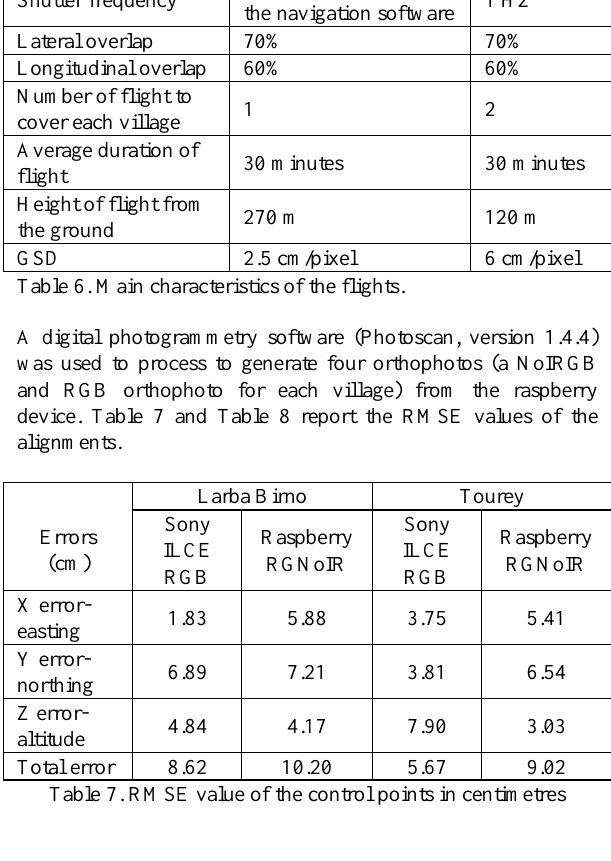
Figure 6: Area of the study. The villages of Tourey and Larba Birno both lay on the left side of the Sirba.